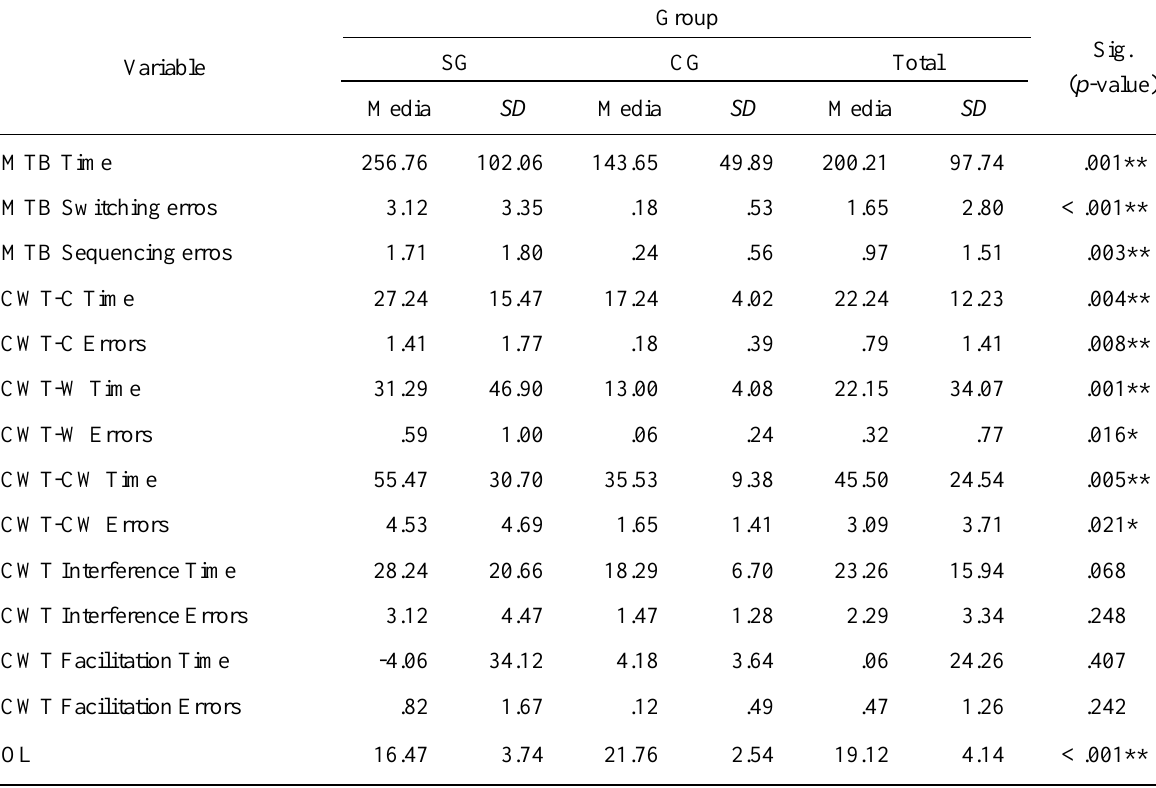
Comparison of Average Executive Functions Tests Scores among Groups